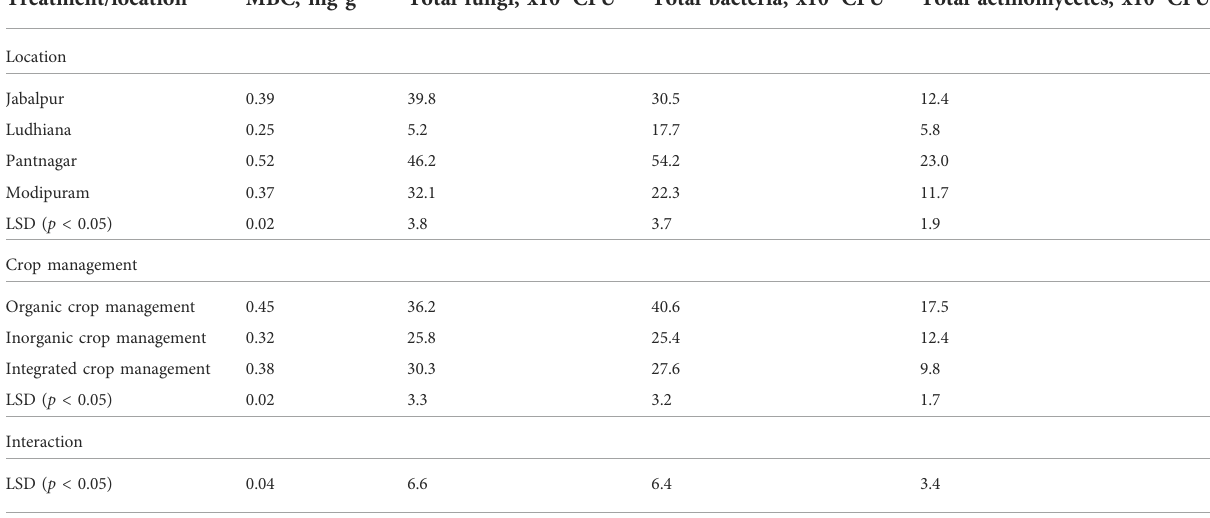
TABLE 3 Effect of spatial and crop management on microbial diversity in the rice – wheat system. Treatment/location